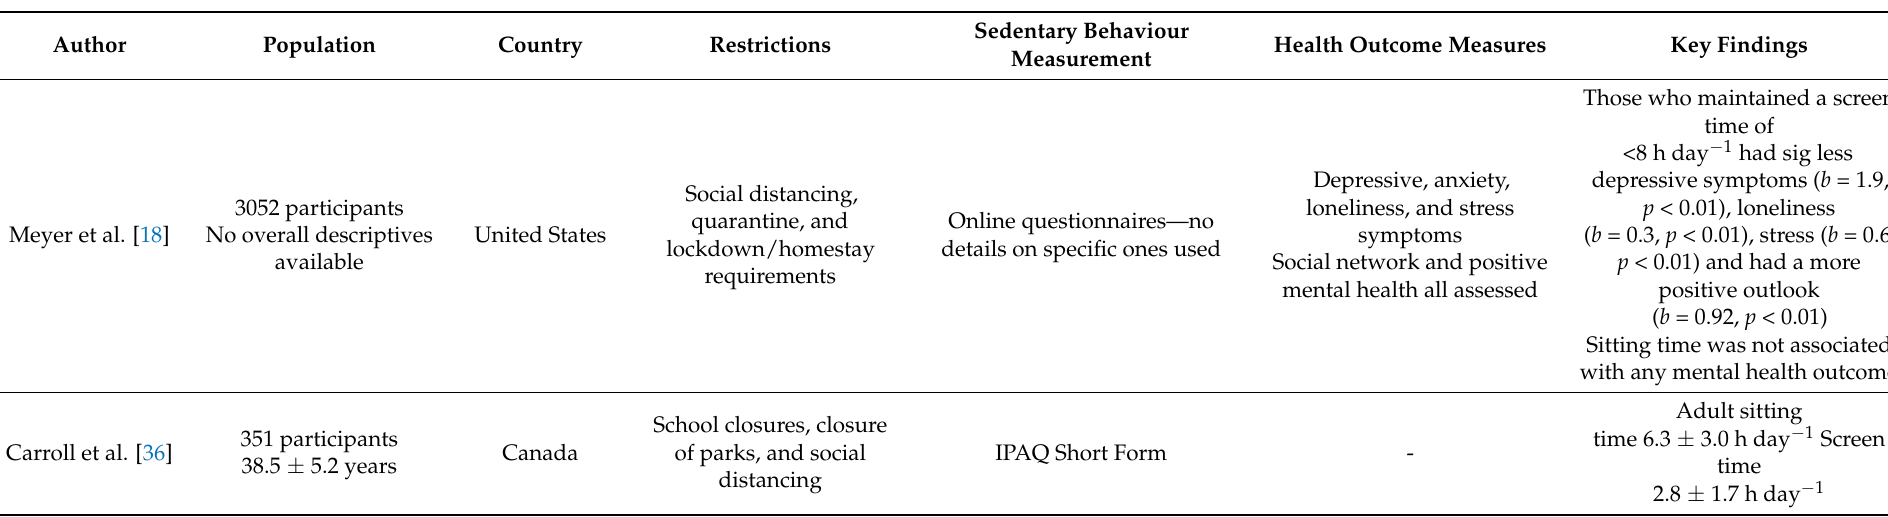
Table 2. Data extraction of studies measuring sedentary time and/or behaviour during COVID-19 in adults and older